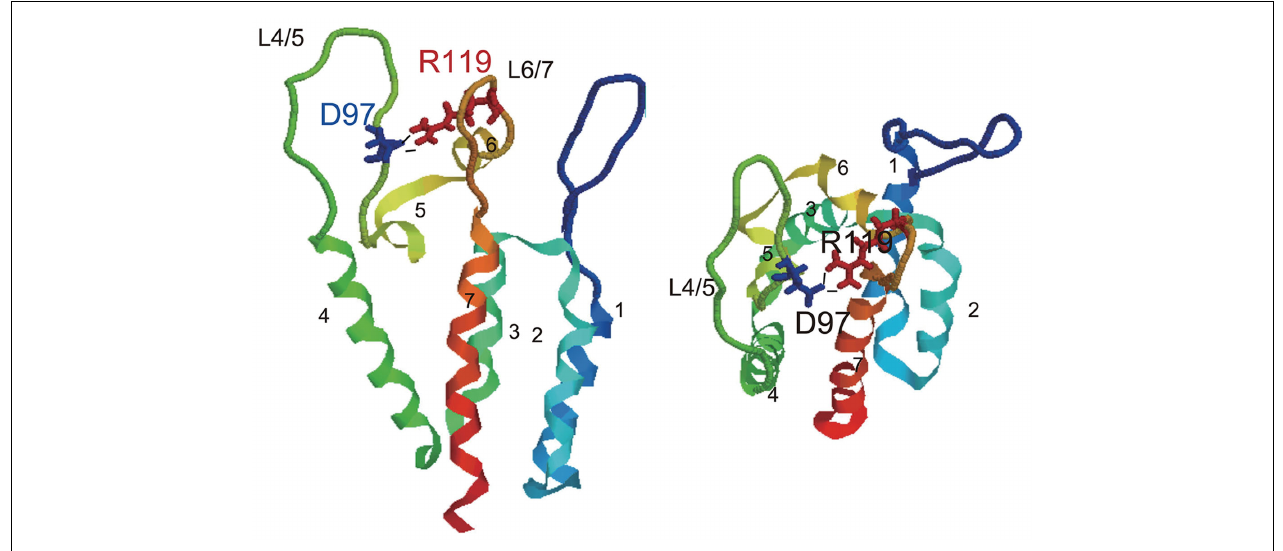
chains of glutamic acid at the 97th (D97) and arginine at the 119th (R119) positions, respectively. Black lines indicate hydrogen bonds between D97 and R119. Models are shown from two different